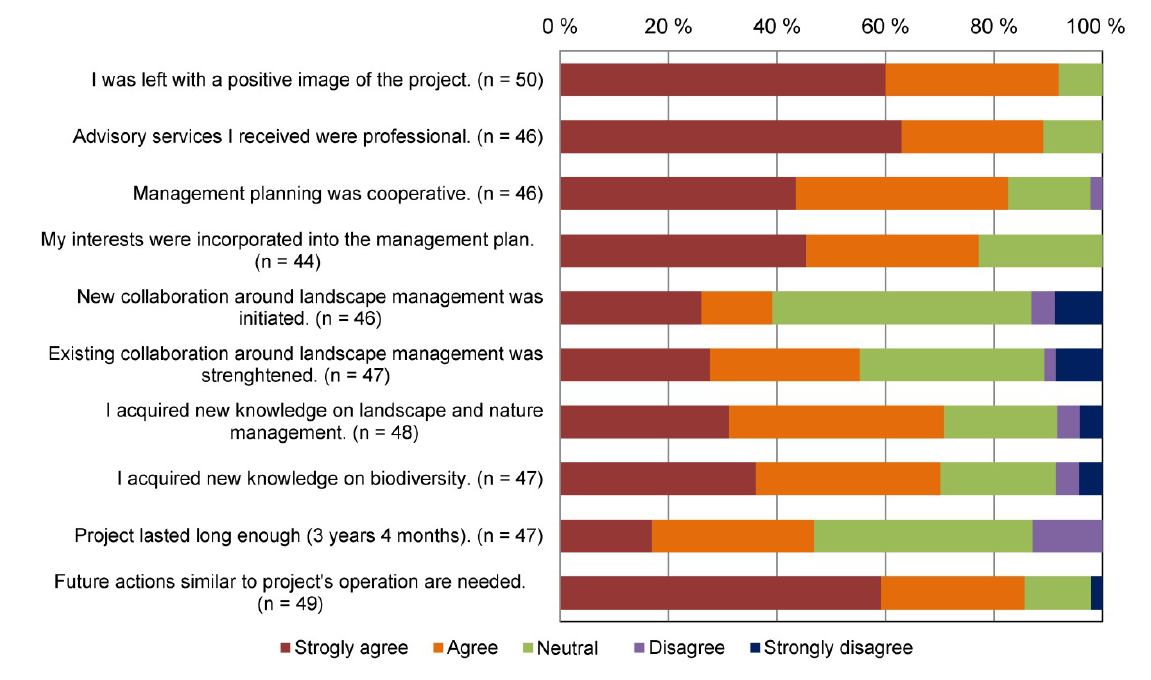
= 148). Then, the same total bars, n = 65). total